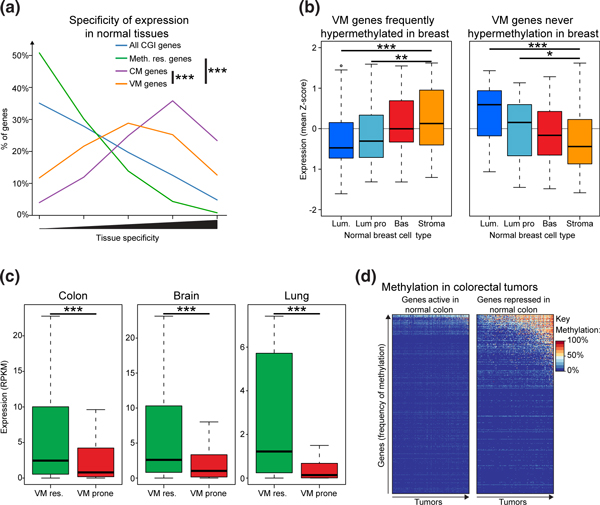
Expression patterns in normal tissues explain differential susceptibility to hypermethylation in cancer. (a) Consistently hypermethylated genes are more tissue specific than variably hypermethylated genes. Shown are histograms of tissue-specificity scores (as Figure 2b) observed at hypermethylation prone genes that were consistently or variably methylated in different tumor types. Differences between gene sets were tested using Wilcoxon rank sum tests (*** P < 0.001, ** P < 0.01 and * P < 0.05). (b) Variably hypermethylated genes with differential susceptibility in breast cancer are differentially expressed in normal breast tissue. Shown are boxplots of the relative level of expression in different cells from normal breast found at VM genes that are either frequently or never hypermethylated in breast tumors [85]. Differences between cellular fractions were tested using Wilcoxon rank sum tests. Lum = luminal epithelial cells, Lum Pro = luminal progenitor cells, Bas = basal myoepithelial cells, Stroma = breast stromal cells. (c) Variably hypermethylated genes that are prone to hypermethylation in tumors are repressed in the corresponding normal tissue. Shown are boxplots of the expression levels measured for VM genes with different susceptibility in individual tumor types in the corresponding normal tissues. Res = never hypermethylated in tumors, Prone = frequently hypermethylated in tumors. Differences between gene groups were tested using Wilcoxon rank sum tests. (d) Repressed genes are more prone to hypermethylation than active genes in colorectal cancer. Shown are heatmaps of the methylation levels of CGI promoter genes that are unmethylated in normal colon tissue and are either activated (left) or repressed (right) in normal colon as compared to normal liver. The 356 repressed genes are methylated to a significantly higher level than the 1,465 active genes (one-sided Wilcoxon rank sum test P = 1.6x10-7). CGI, CpG island; VM, variably methylated.